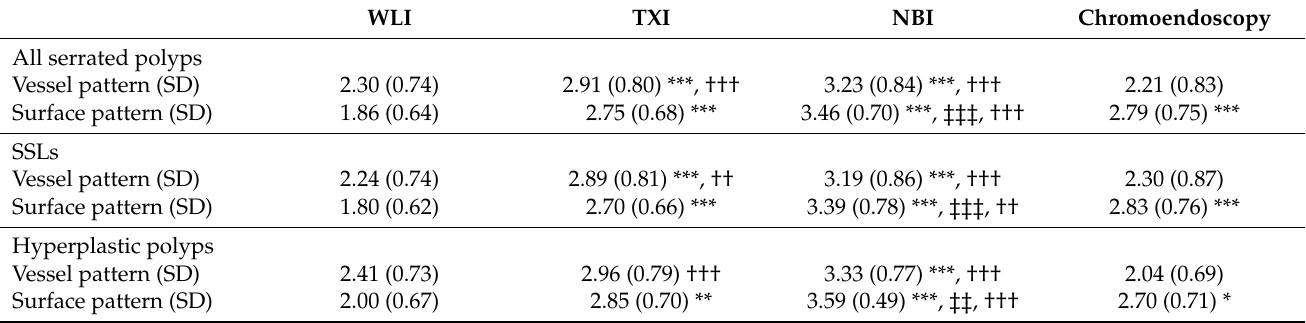
Table 3. Visibility scores of vessel pattern and surface pattern with magnification for WLI, TXI, NBI, and